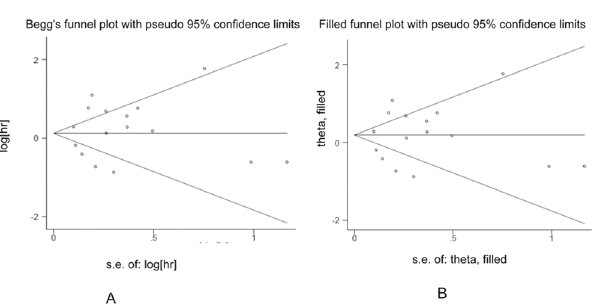
Fig 7. Funnel plots in the context of OS without and with trim and fill. The pseudo 95% CI is computed as part of the analysis that produces the funnel plot, and corresponds to the expected 95% CI for a given SE.